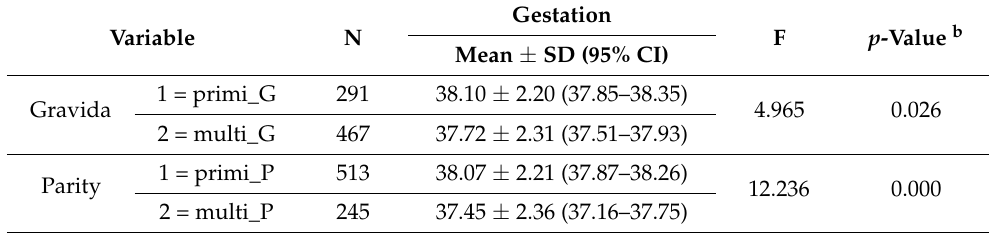
Table 3. Effects of different gravidity and parity on gestational weeks of SCH